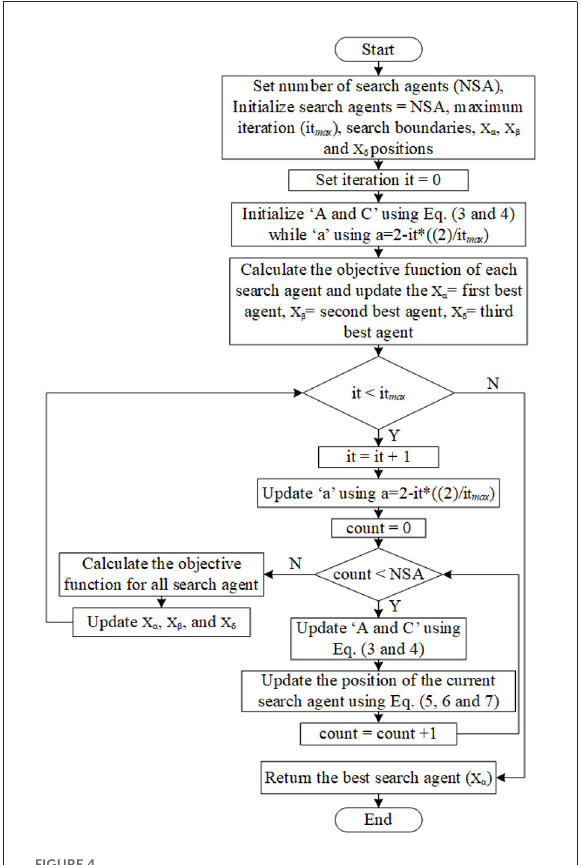
FIGURE4 Flowchart of the GWO